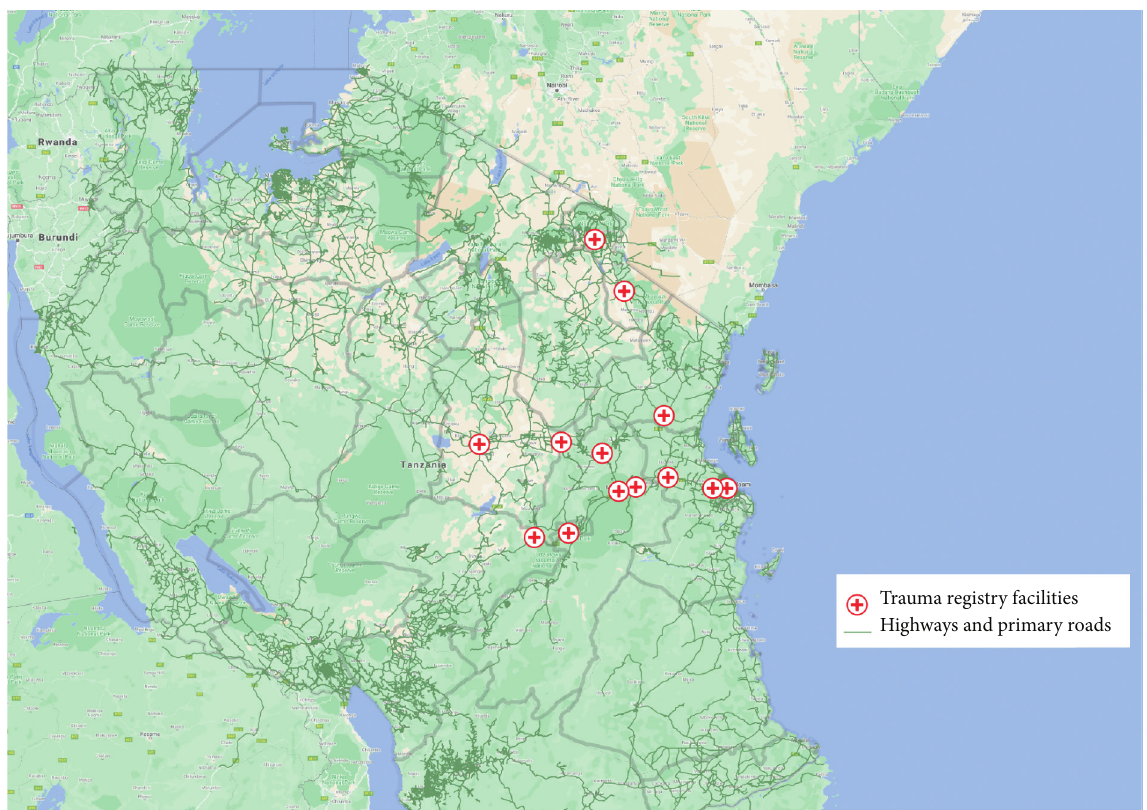
Figure 1: Map of Tanzania showing the location of each health